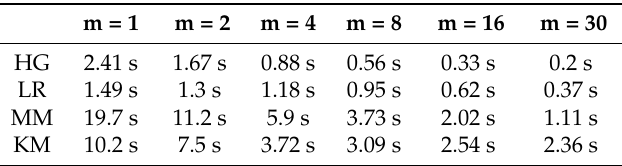
Table 2. Maximum Execution Times in